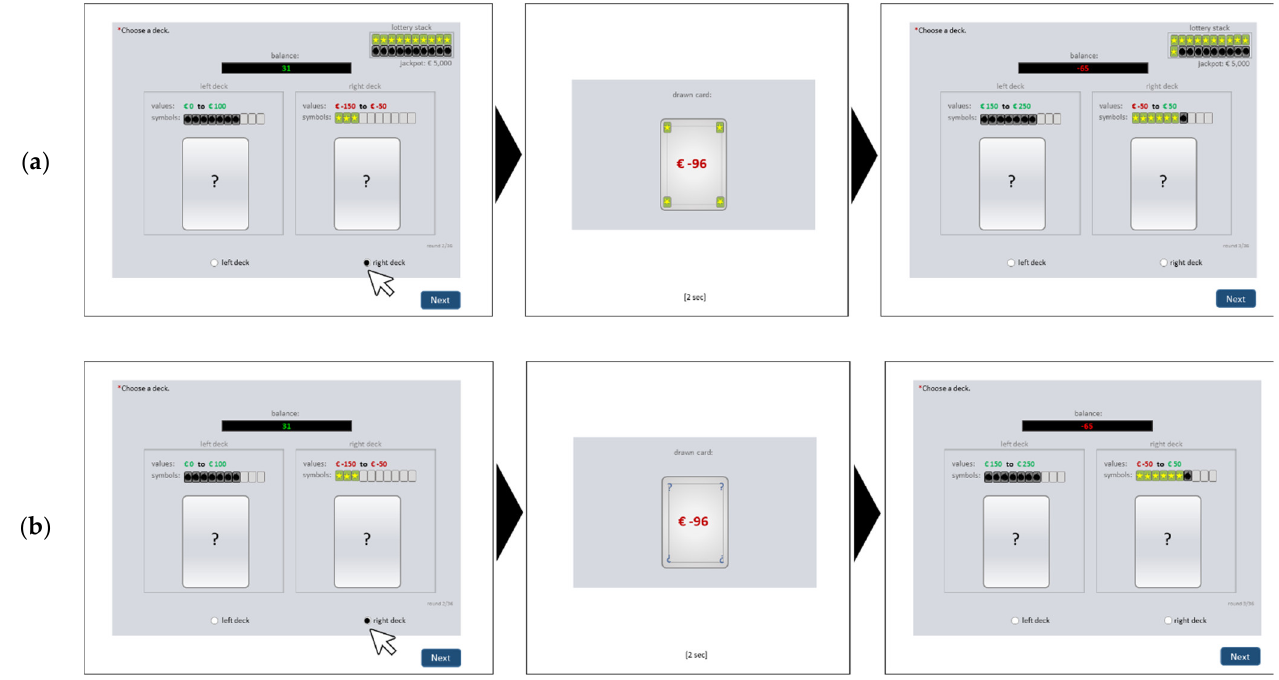
Figure 1. Exemplary trial in the online version of the Cards and Lottery Task (CLT). In this example, in round 2 (left screen), the right deck is chosen. It contains ten cards with negative values between -150 to -50, and three of the cards have a star symbol. The drawn card (middle screen) has a value of -96 and a star symbol. The value was offset against the current account balance, leading to a new balance of -65 in round 3 (right screen). The star was added to the long-term account, “lottery stack”, which increased the chance to win the jackpot at the end. In the next round, both decks contain ten new cards each. Accordingly, the value ranges and/or contained number of cards with star/bomb symbol change. In the current example (right screen) the left deck now contains cards with values between 150 to 250 and seven bomb-cards; the right deck now contains cards with values between −50 and +50 with six cards of the cards having a star and one card having a bomb symbol. The example is shown for two feedback variations: ( a ) full feedback is provided by showing the drawn card’s value and symbol, as well as the actual stats of the lottery stack (as in the five trial rounds); ( b ) partial feedback is provided by showing only the short-term effects and hiding the drawn card’s symbol and the lottery stack (as in the actual task). For a more detailed description of the CLT see [44]. The Risk-Propensity Scale (RPS; [62]) was used as a self-report measure of risky ranging from 1 (“totally disagree”/“risk avoider”) to 9 (“totally agree”/“risk